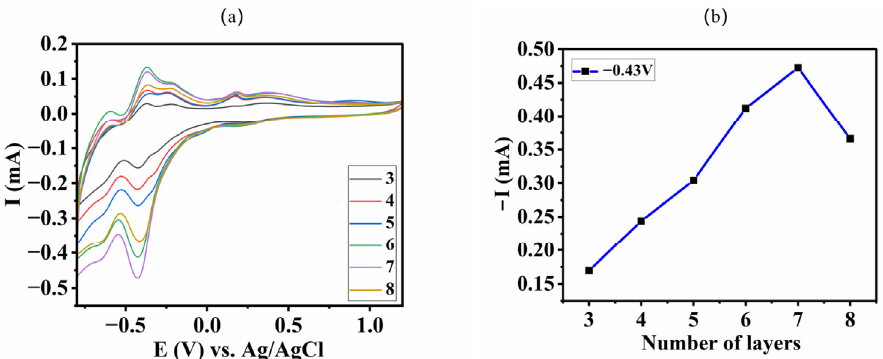
Figure 8. CV curves of the ITO/(Cu 4 P 4 W 30 /PDDA-GO) n electrode (n = 3, 4, 5, 6, 7, and 8) in 10 µm 2,4- 2,4-DNPH at pH 3 ( a ) and the relationship between the reduction currents at − 0.43 V and the layer DNPH at pH 3 ( a ) and the relationship between the reduction currents at -0.43 V and the layer num- number ( b ), scan rate: 50 mV · s − 1 ber ( b ), scan rate: 50mV·s − 1 .